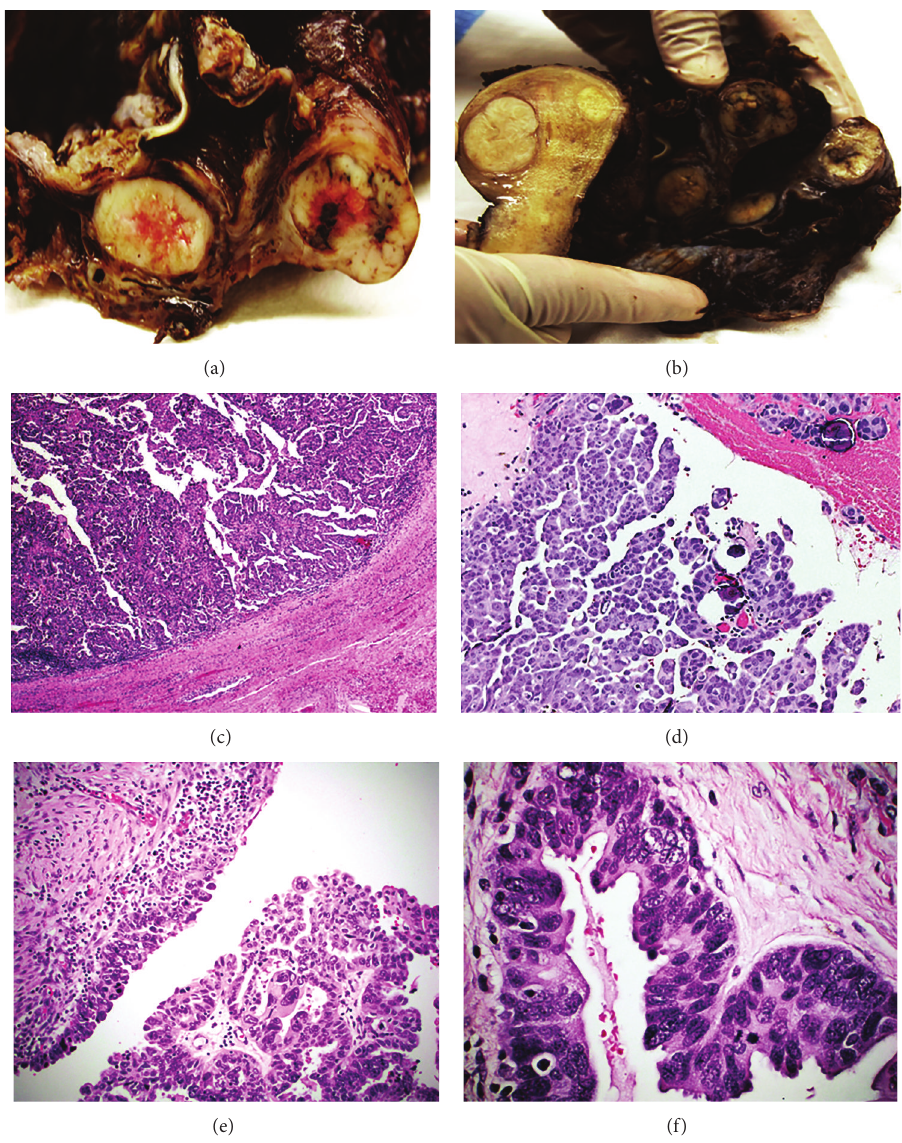
Figure 2: (a) is the macroscopic image of the left fallopian tube which shows a cross section of sausage-like white fleshy mass within what appears to be part of the tube. The remainder of the tube is destroyed and cystic. (b) shows the right tube and uterus. The right tube is somewhat similar to the left and shows 2 tumour masses. The uterus with simple leiomyomas is also shown. (c) is a panel that is a low power view of the left tube with a papillary carcinoma (Haematoxylin and Eosin stained section, original magnification of × 10) and (d) is high power view of the right tube with a serous carcinoma, displaying a micropapillary growth pattern with occasional psammoma bodies (Haematoxylin and Eosin stained section, original magnification of × 40). (e) shows a higher power view of the left tubal tumour (right side) and high grade dysplasia in lining epithelium on the left side (Haematoxylin and Eosin stained section, original magnification of × 60) and (f) shows high grade dysplastic epithelium in the right tube (Haematoxylin and Eosin stained section, original magnification of × 60).